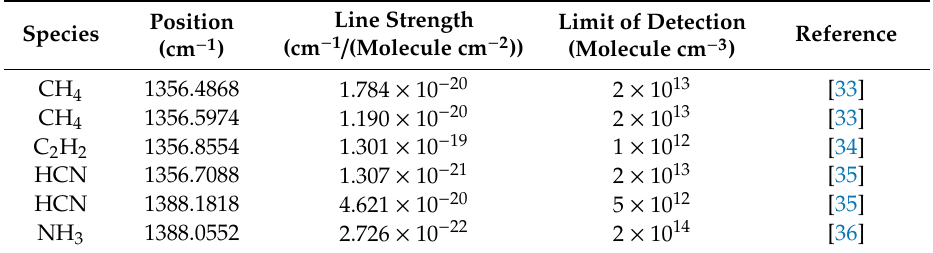
Table 2. Monitored species and their respective spectral positions, absorption line strengths at room temperature, and estimated limits of